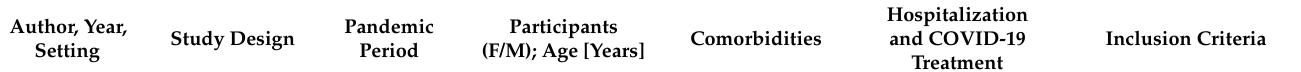
Table 2. General characteristics of included